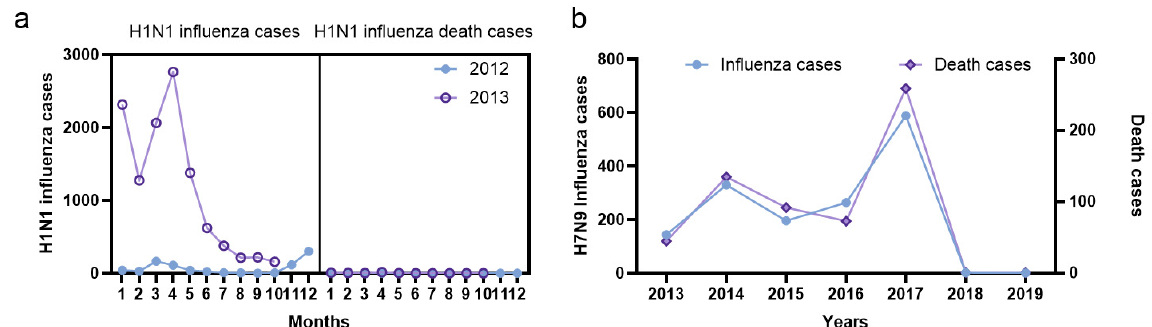
Figure 2. The numbers of H1N1 and H7N9 influenza infections and related deaths. ( a ) H1N1 influenza infections and related deaths in the years 2012 and 2013, ( b ) H7N9 influenza infections and related deaths during the 2013–2019 period (data were obtained from the Bureau of Disease Prevention and Control) [20].